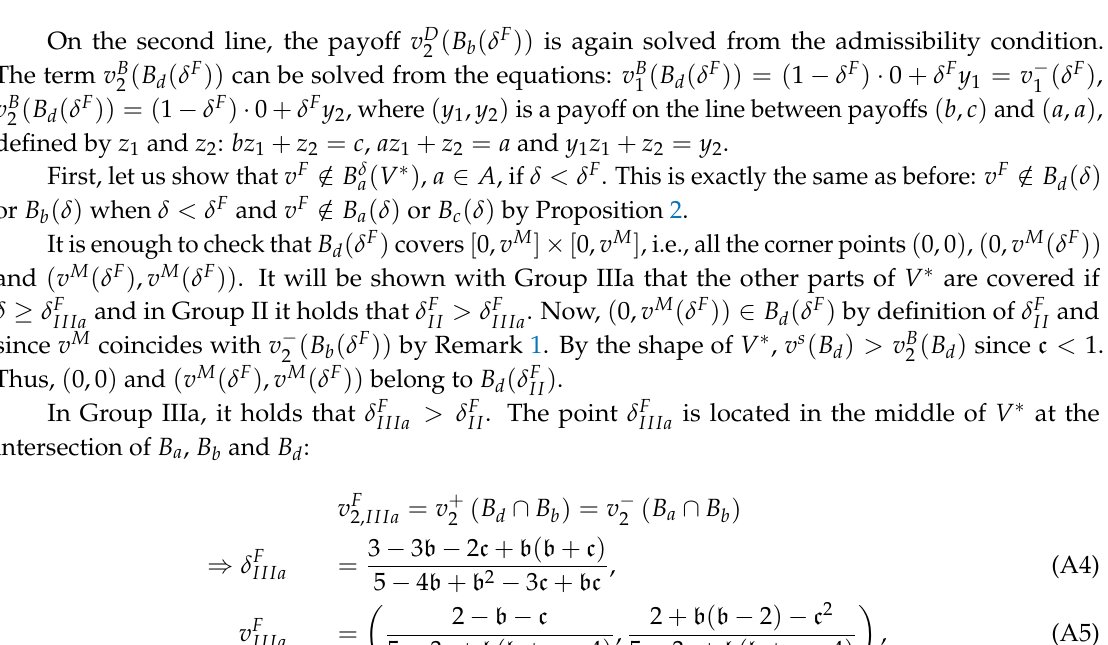
Figure A1. Admissible payoffs in Groups II, IIIa and IV. ( a ) Group II and IIIa; ( b ) Group